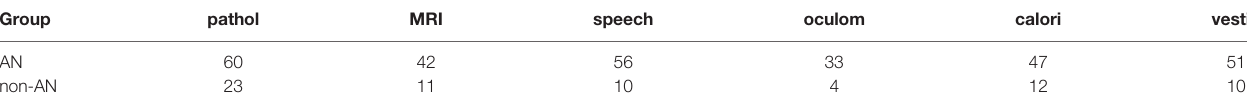
pathol, the fi nal pathological resultafter surgery;MRI, MRIresult before surgery;speech, audiometry before surgery; oculom, including saccadetest, smooth pursuit test, optokinetic test, gaze test, and spontaneous nystagmus; calori, caloric test before surgery; vestib, vestibular function impairment before